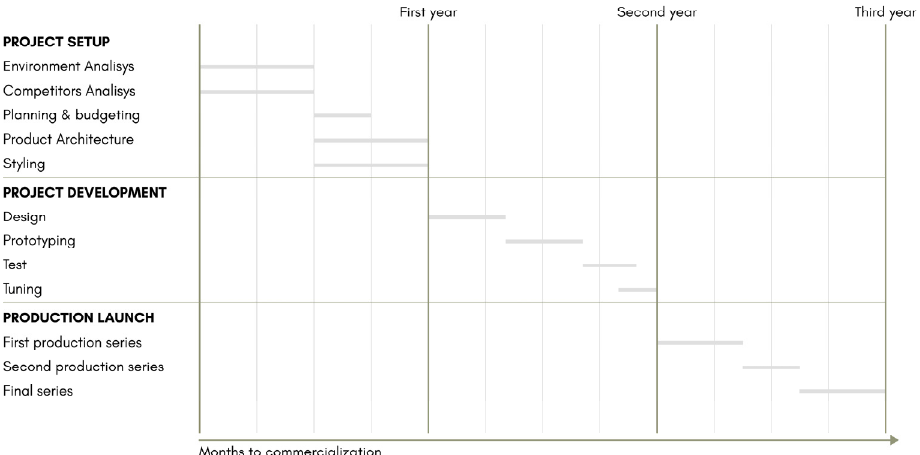
Figure 12. Gantt Plan.